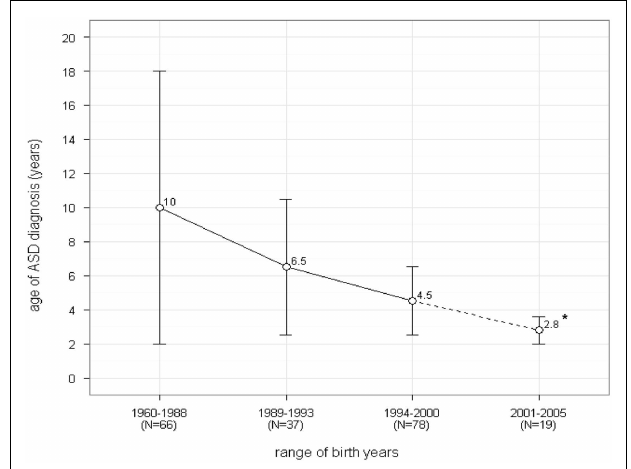
FIGURE 1 | Changes in age ofASD diagnosis in France during the last 40years [extracted from Ref. (46); courtesy of Claude Bursztejn] . *The dot line indicates that the 2001–2005 result should be regarded with caution as based on only N = 19